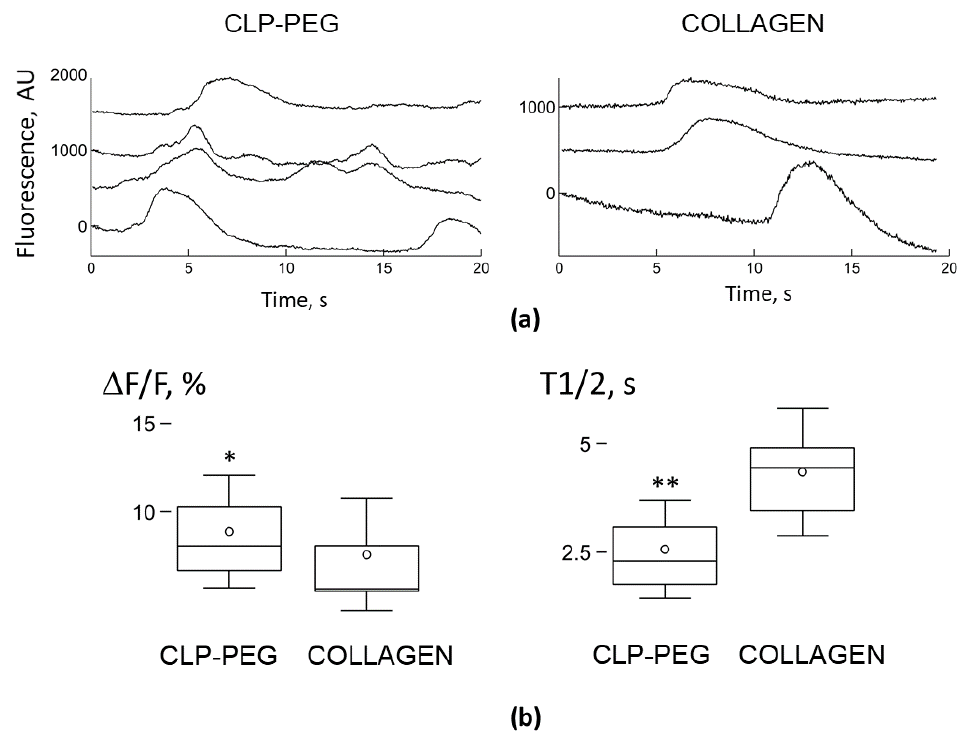
Figure 7. Representative traces of microglial Ca 2+ concentration changes in cerebellar cell cultures after 7 days in vitro on CLP-PEG and collagen hydrogels ( a ) and quantitative evaluation of the Ca 2+ signalling properties ( b ). Box-and-whisker plots in ( b ) illustrate the difference in the relative signal amplitude, ∆ F/F, and the time of decay to a half-amplitude, T1/2, s, of spontaneous Ca 2+ -sensitive fluorescence signals in microglial cells. The error bars indicate the standard deviation, shoulders of boxes indicate 25–75% intervals, a median of the data is highlighted by a horizontal line, and the mean is indicated by a circle. * p < 0.05, ** p < 0.01. For ∆ F/F, p was from the Kolmogorov-Smirnov